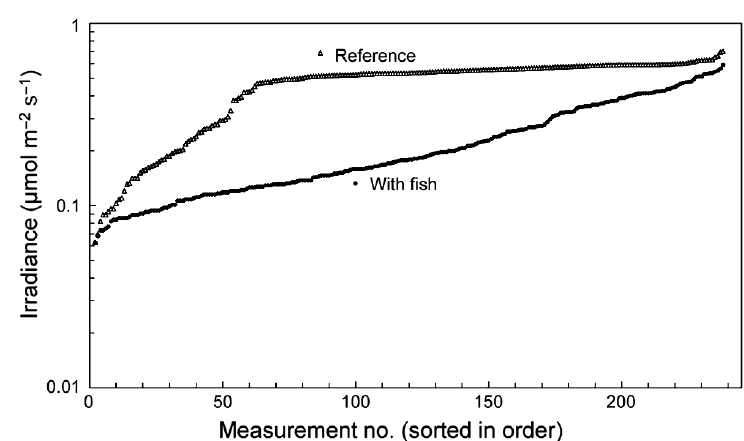
Fig. 4. Light irradiance measured 3 m from a metal halide lamp at a reference depth in cages (2 m depth with few Atlantic salmon present between lamp and sensor), compared to measurements at the depth of the highest biomass (5 m) with fish between the lamp and the measurement probe. Data were stored every 15 s, sorted and plotted in increasing order. The reference data were collected between 21:00 and 22:00 h (mean ± SD; 0.47 ± 0.16 µmol s −1 m −2 ) and data with fish present between 23:00 and 00:00 h (0.23 ± 0.13 µmol s −1 m −2 )